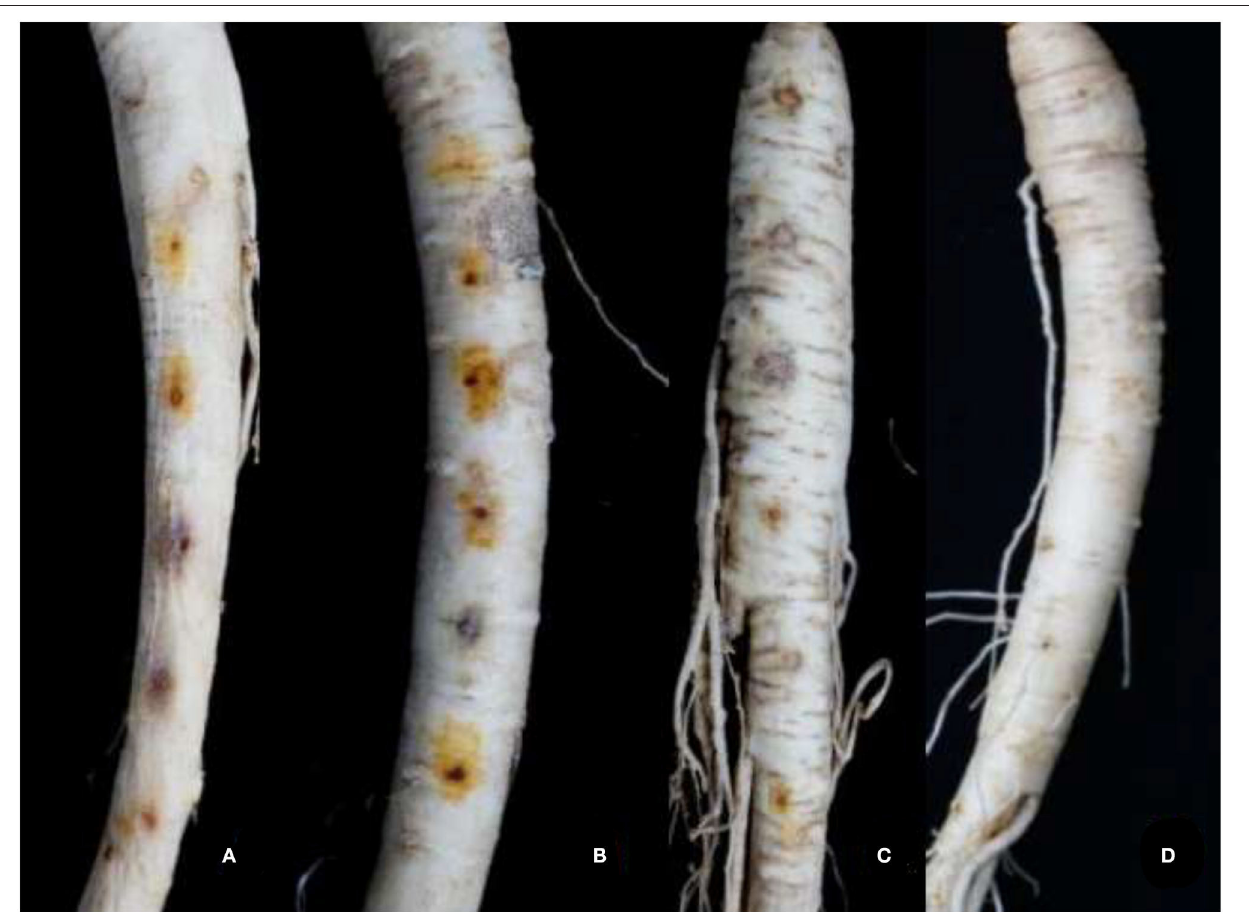
FIGURE 4 | The symptoms of ginseng root based on the different species of Cylindrocarpon infected. (A) C. destructans ; (B) C. destructans var. destructans ; (C) I. robusta ; (D) Control treatment.